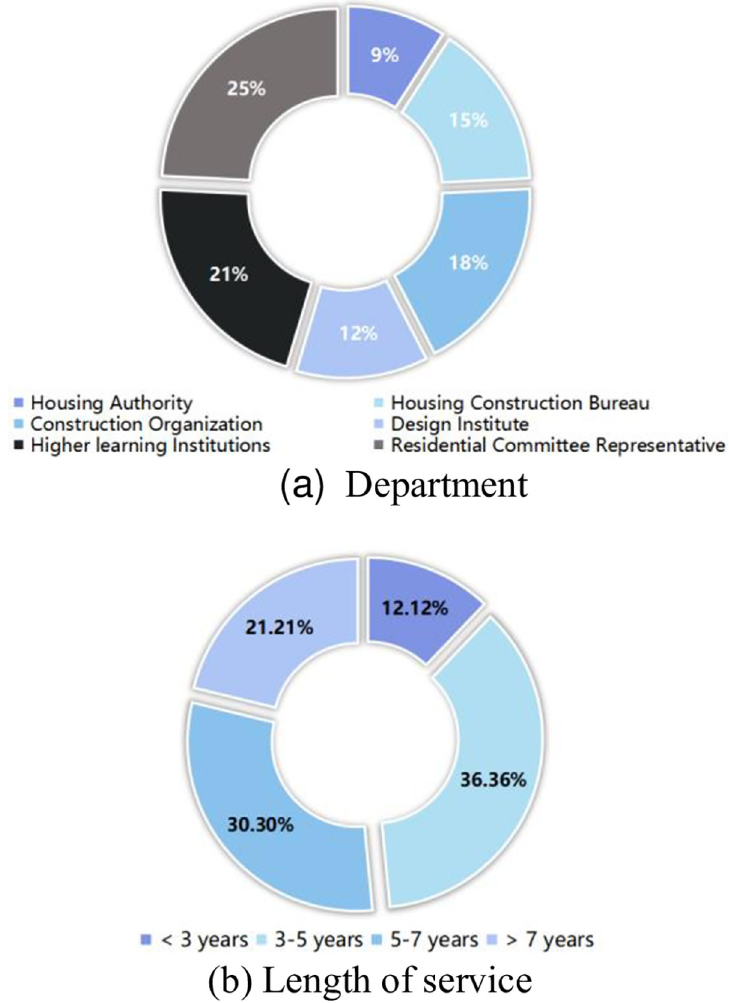
Fig 6. The personnel of the pre-survey. (a) Department. (b) Length of